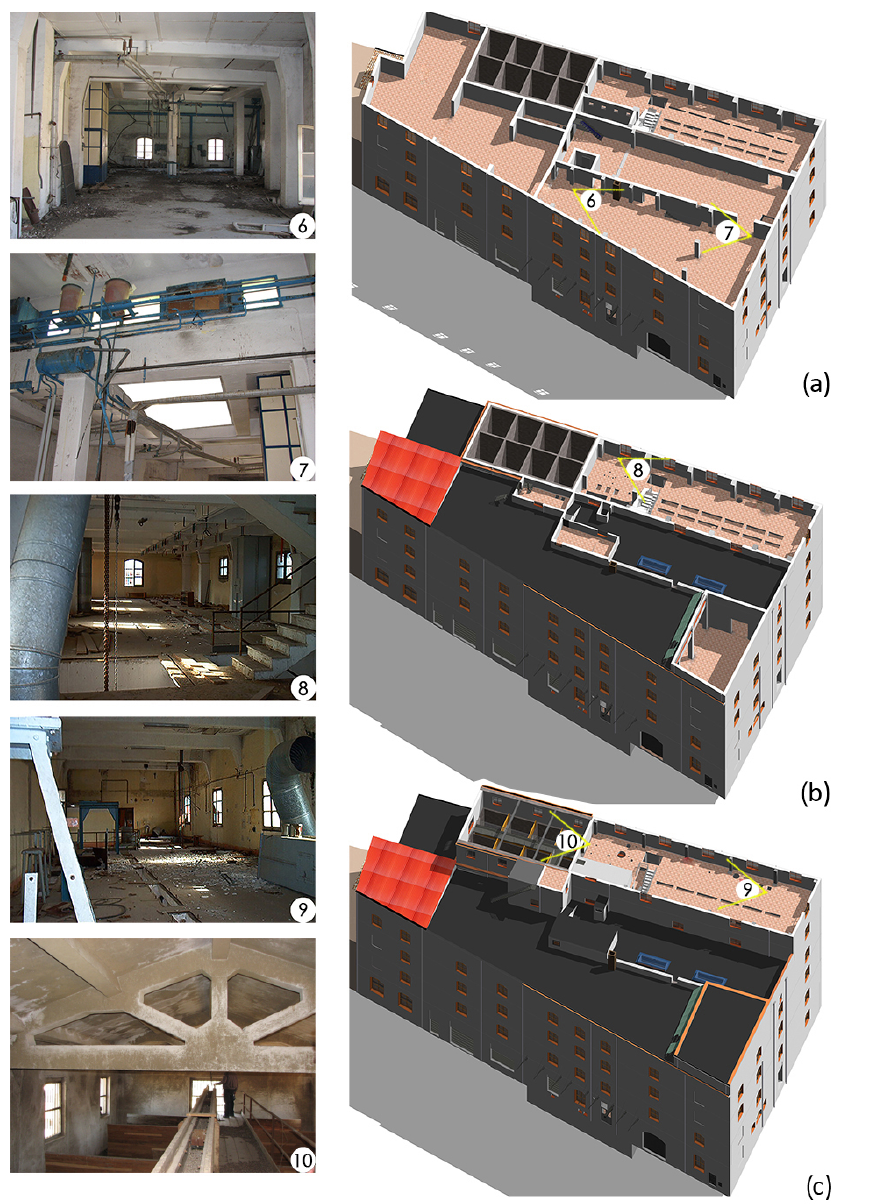
Figure 10. ( a ) Fourth floor; ( b ) Fifth floor; ( c ) Sixth